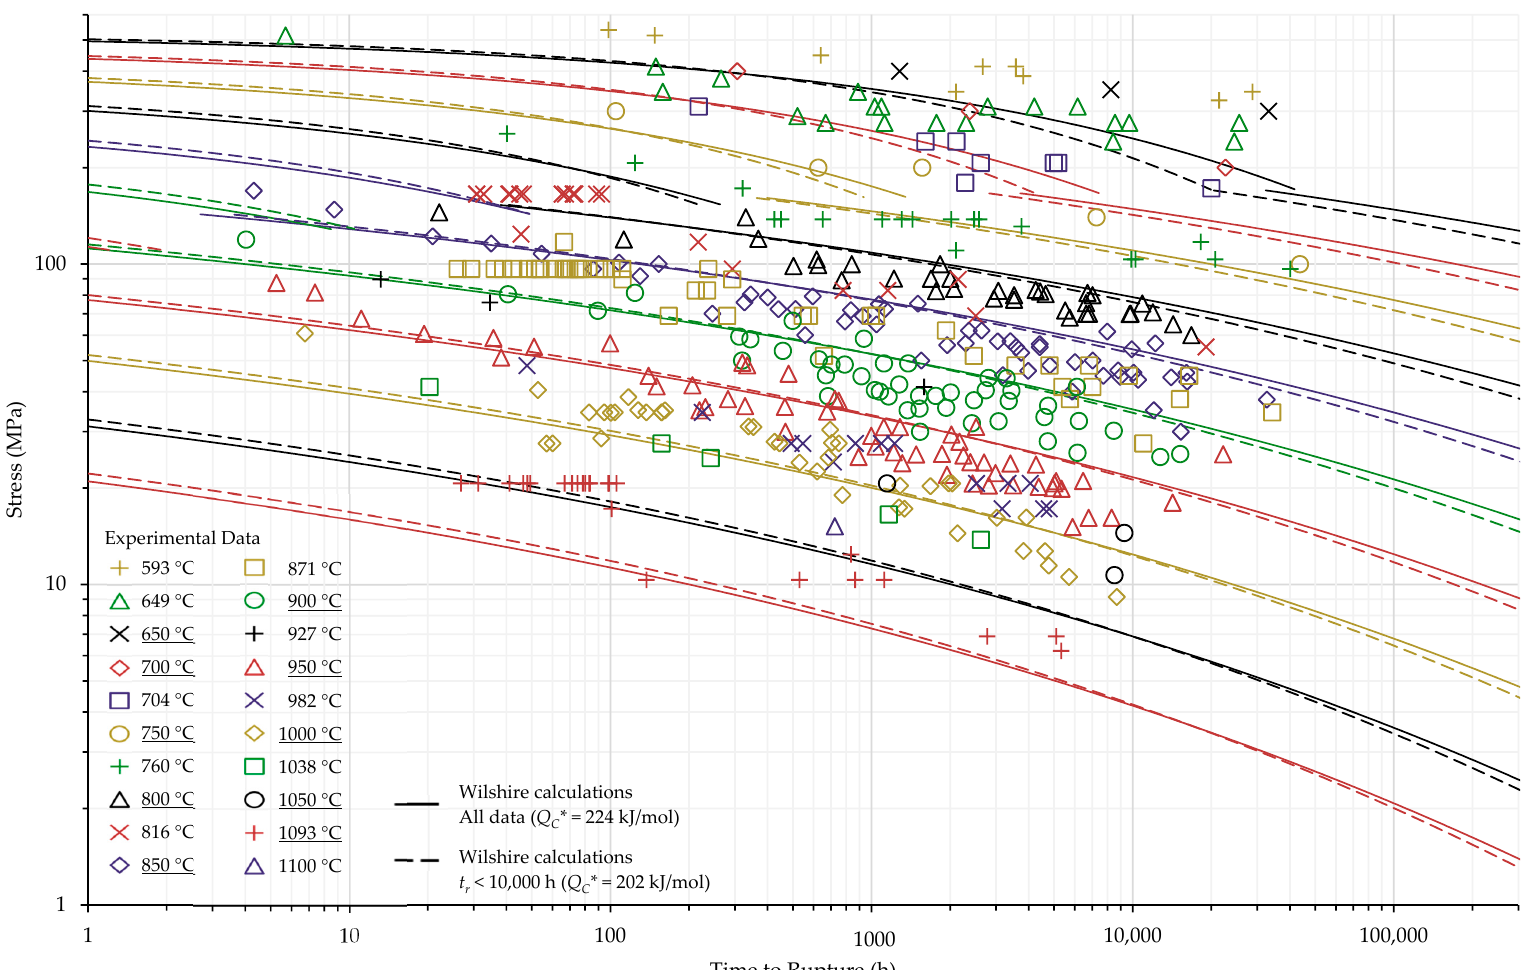
Figure A11. Split region calculations of the Wilshire equation with Q ∗ determined by optimizing the correlation of data on a Wilshire plot for Inconel 617 shown at underlined temperatures.